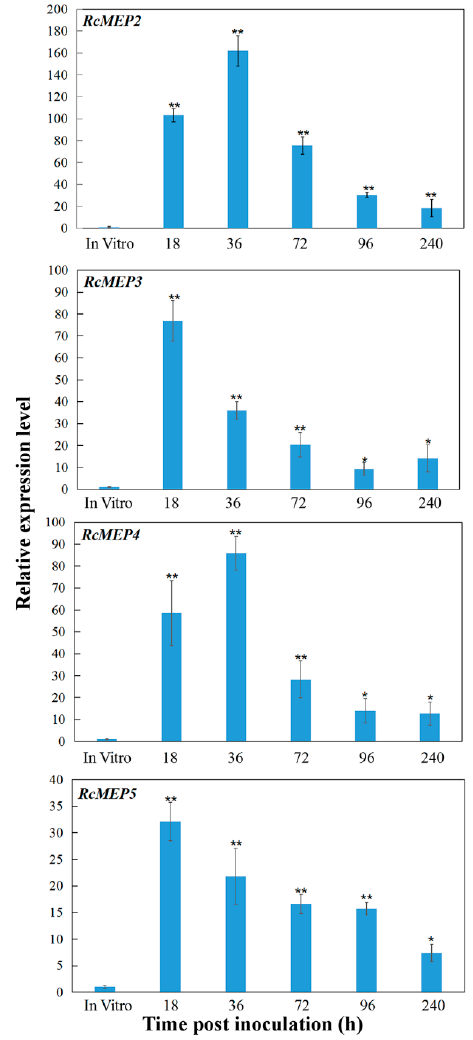
Figure 2. Transcriptional profiles of RcMEP2-RcMEP5 genes in Rhizoctonia cerealis during the infection to wheat. The R. cerealis Actin gene was used as an internal control to normalize the data. The relative transcriptional abundances of RcMEP2-RcMEP5 were examined during the infection process to wheat stems / sheaths, including five di ff erent infection time points (18, 36, 72, 96, and 240 h post inoculation (hpi)) and compared to in vitro culturing. Error bars were calculated based on three replicates. Asterisks indicate significant di ff erence (** p < 0.01 or * p < 0.05, t -test) between the pathogen-inoculated sample and in vitro